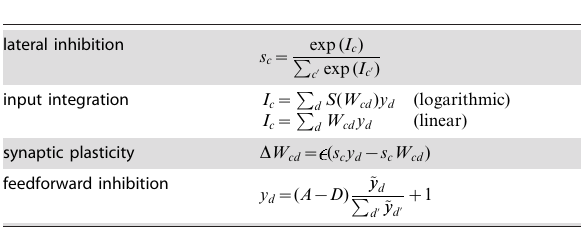
Table 1. Learning in neural